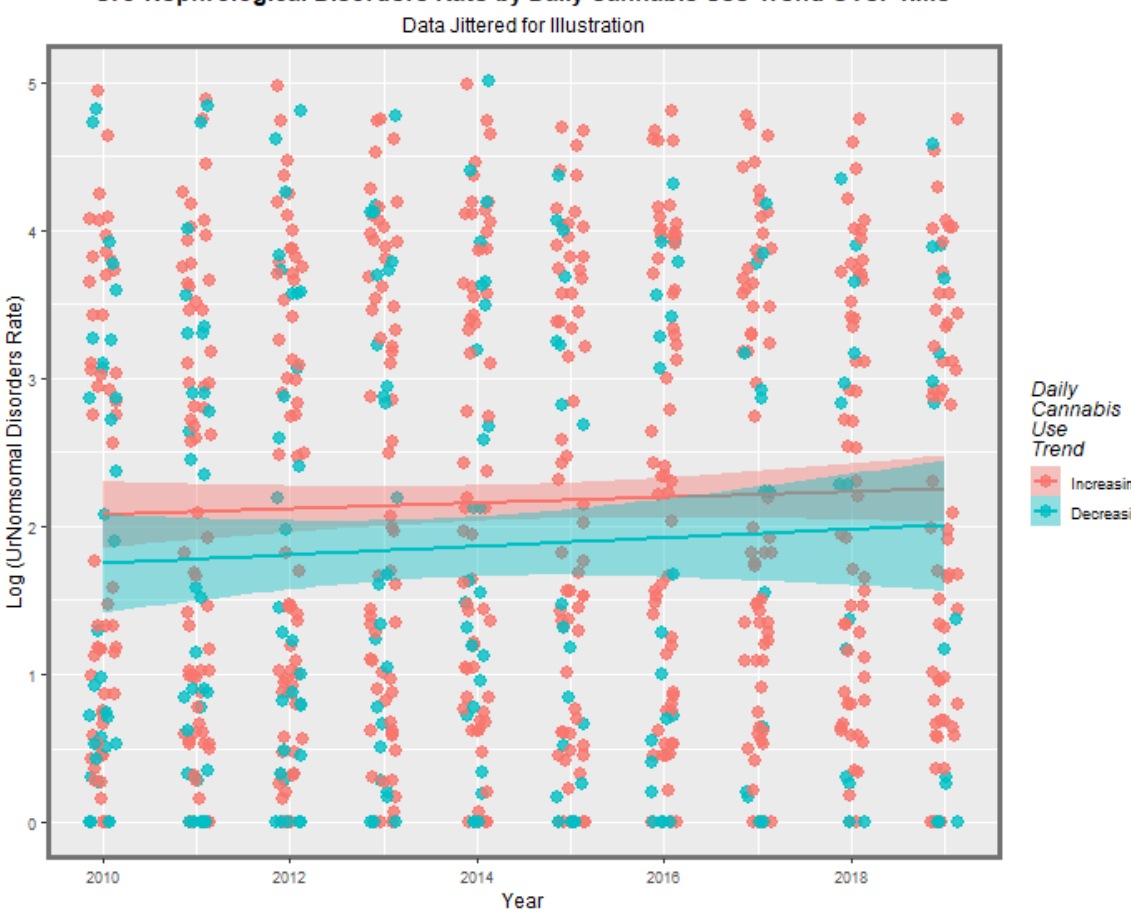
Figure 12. Overall rate of log (uronephrolgical congenital anomaly rate) against time by rising of falling daily cannabis use rates (see Methods section for country classification).